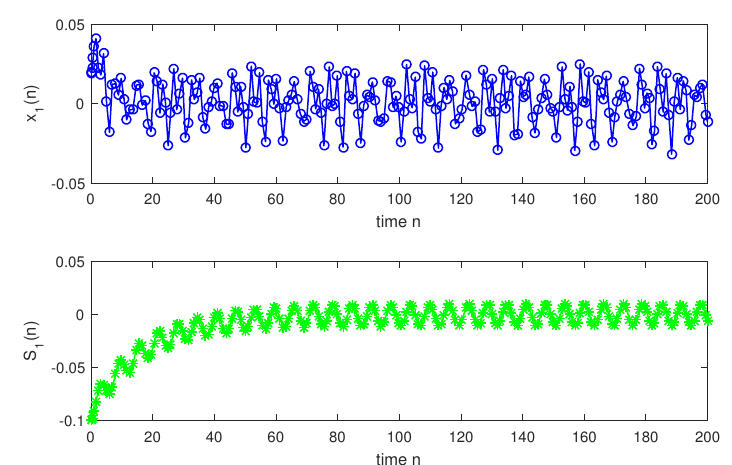
Figure 5. Continuous situation T = R : S 1 ( t ) , S 2 ( t ) , S 3 ( t ) .